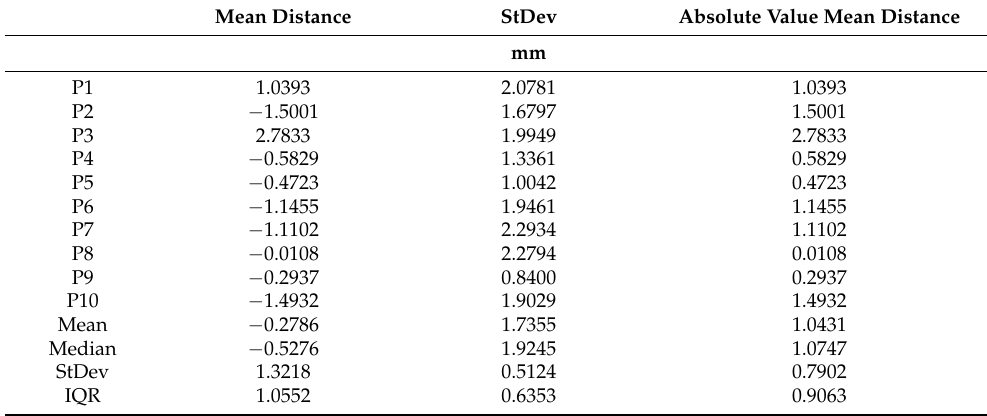
Table 5. FCS overlap data for each